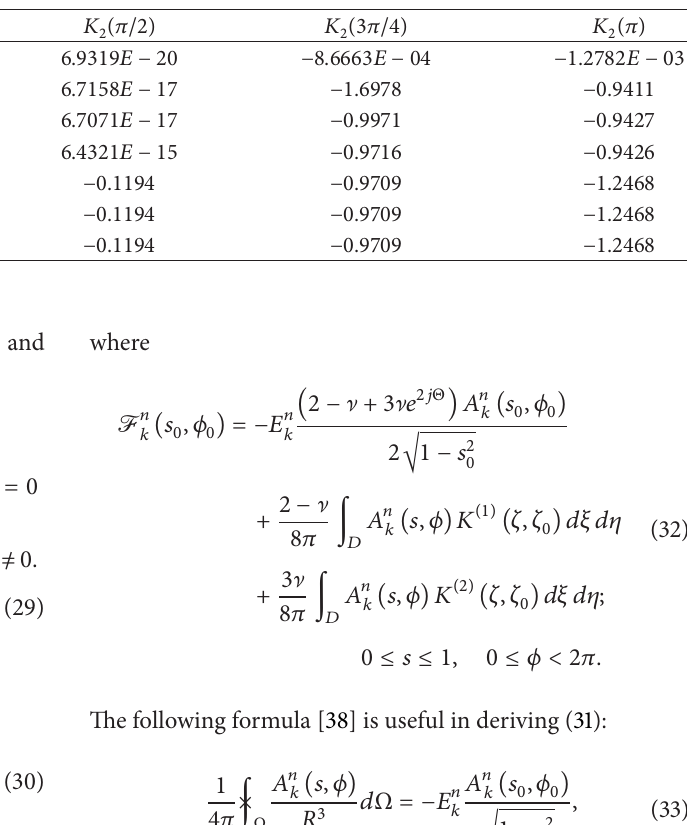
Table 1: Numerical convergence for the sliding mode stress intensity factor, 𝐾 2 (𝜙) , for 𝑚 = 1 when 𝑐 = 0.1